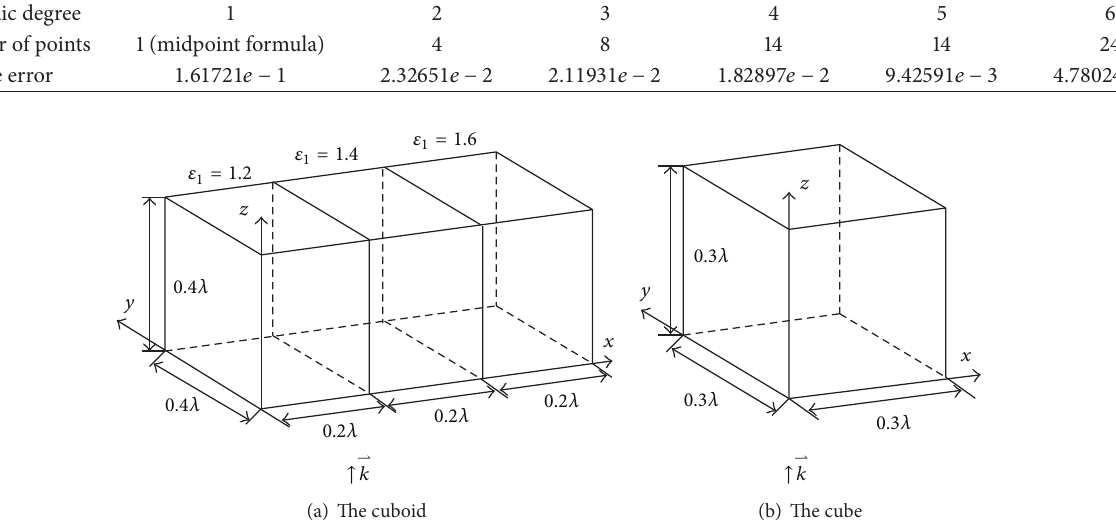
Figure 3: The partitioned homogeneous cuboid and the inhomogeneous